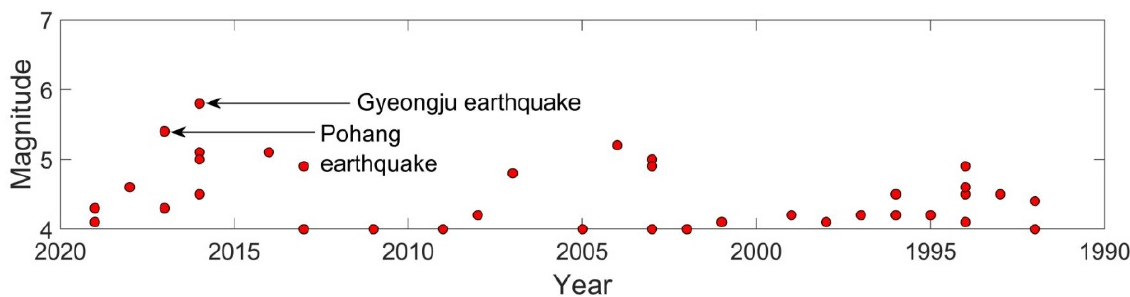
Figure 1. Variation of earthquake magnitude in South Korea from year 1992–2019 (data obtained from weather.go.kr, accessed on 5 September 2019).